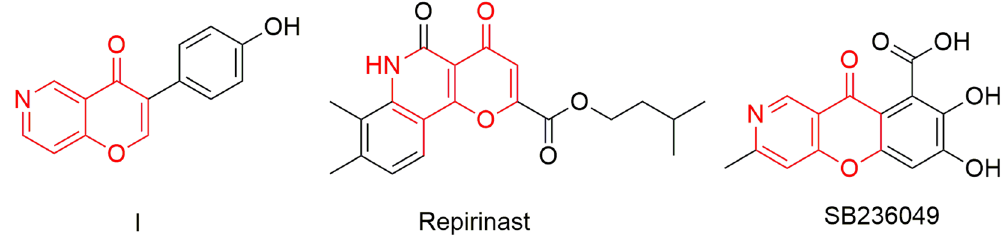
Figure 1. Selected examples of biological active and naturally occurring compounds containing azachromone units.